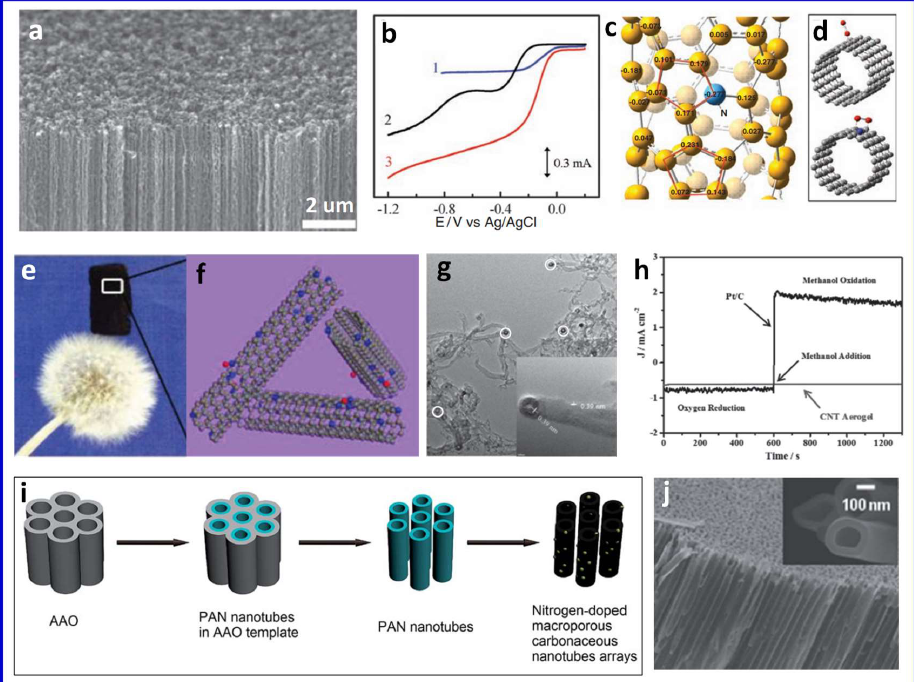
Figure 5. ( a ) Scanning electron microscopy (SEM) image of N-doped VA-CNTs; ( b ) ORR polarization curves of Pt/C (curve 1), VA-CNTs (curve 2), and N-doped VA-CNTs (curve 3); ( c ) Calculated charge density distribution for the N-doped CNTs; ( d ) Schematic representations of possible adsorption modes of an oxygen molecule at the CNTs (top) and N-doped CNTs (bottom). Reproduced from [27], Copyright 2009, American Association for the Advancement of Science. ( e ) Digital photograph; ( f ) model schematic diagram; and ( g ) Transmission electron microscopy (TEM) image of N-doped CNT aerogels; ( h ) Methanol crossover effect measurements of N-doped CNT and Pt/C catalyst at −0.4 V. Reproduced from [37], Copyright 2015, Wiley. ( i ) The fabrication process and ( j ) SEM image of N-doped macroporous carbonaceous nanotubes arrays. Reproduced from [65], Copyright 2014, The Royal Society of